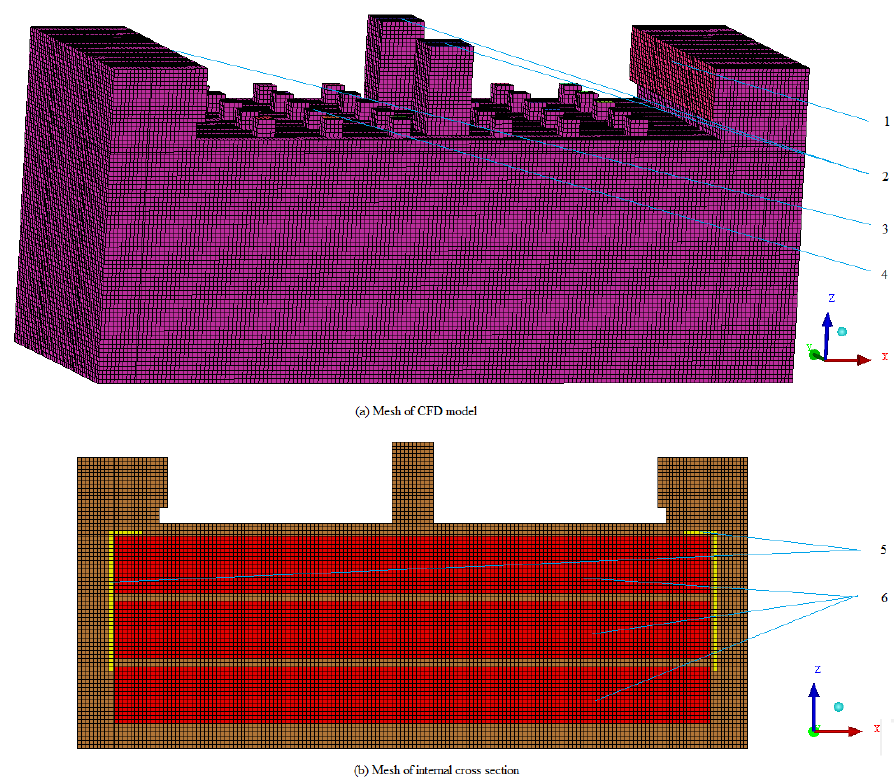
Figure 5. Computational fluid dynamics (CFD) mesh of the tobacco curing barn. 1. Velocity inlet; 2. Moisture discharged hole; 3. Outlet; 4. Air holes; 5. Bamboo curtain; 6. Porous zones.